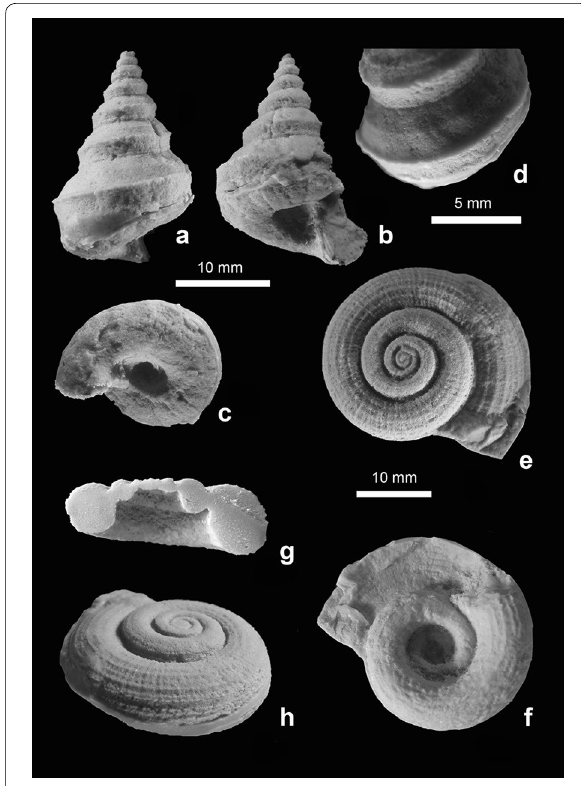
Fig. 3 a-d Worthenia ( Humiliworthenia )? aff. microstriata Nützel et al. 2018, Middle Besano Formation, uppermost Anisian. MCSN 3002: a abapertural view, b apertural view, c basal view, and d detail with growth lines on the ramp. e–h Frederikella cf. cancellata (Zardini 1978), Lower Besano Formation, uppermost Anisian. PIMUZ 29952: e apical and f umbilical view, g transversal section, h apical side view. All images have been obtained producing positive silicon casts from negative external